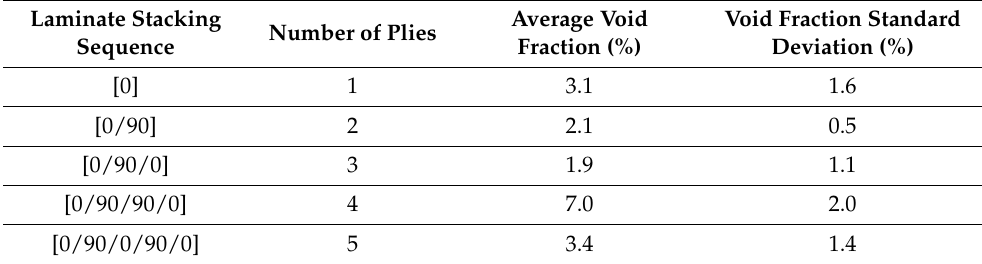
Table 2. Void fractions of continuous fiber laminates.